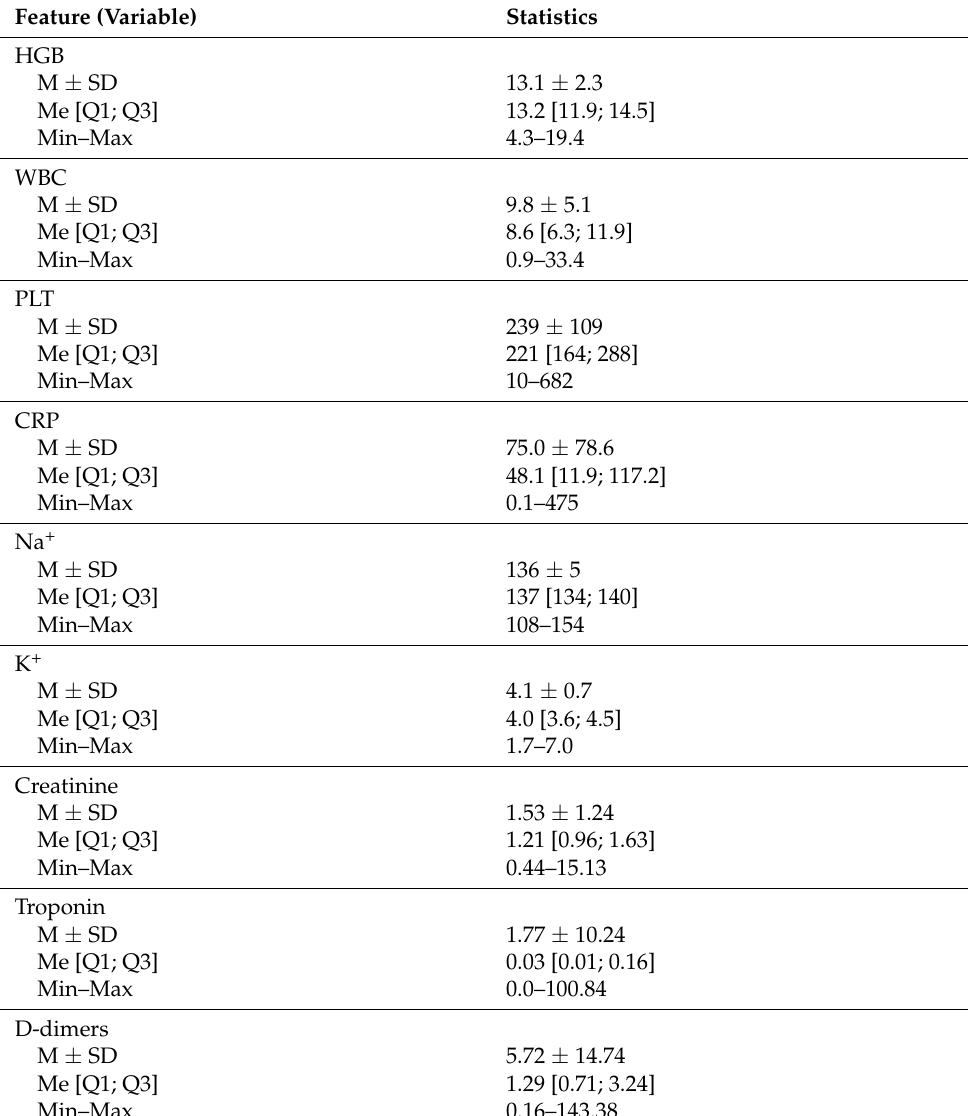
Table 3. Characteristics of blood laboratory test results at the beginning of